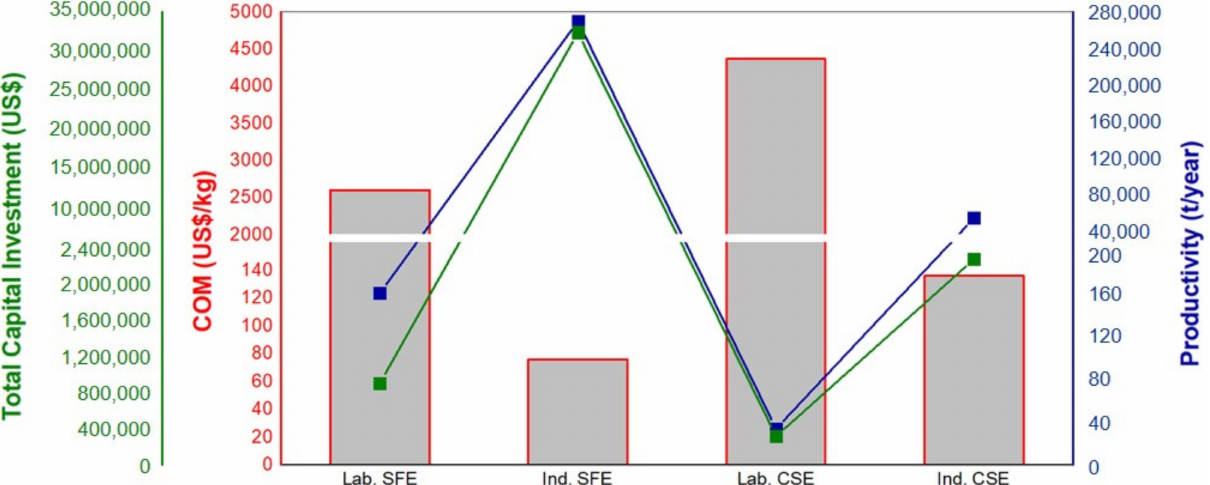
Figure 5. COM, productivity, and total capital investment to produce QPH using SFE and CSE (Lab. SFE: Laboratory supercritical fluids’ extraction; Ind. SFE: Industrial supercritical fluids’ ex- traction; Lab. CSE: Laboratory conventional solvent extraction; Ind. CSE: Industrial conventional solvent